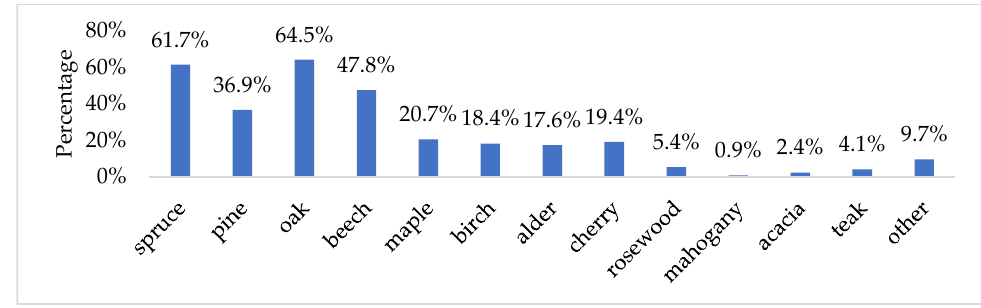
Figure 1. Wood species used in Slovak MSM WFEs.